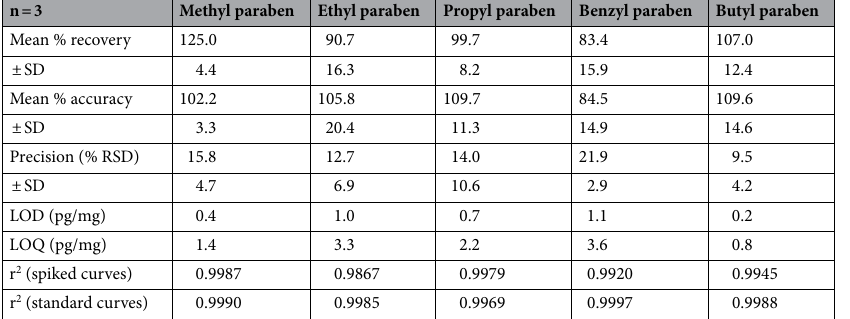
Table 4. Validation parameters of the applied